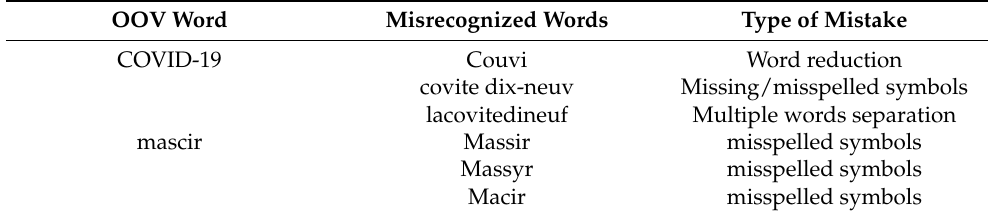
Table 3. Types of misspelled